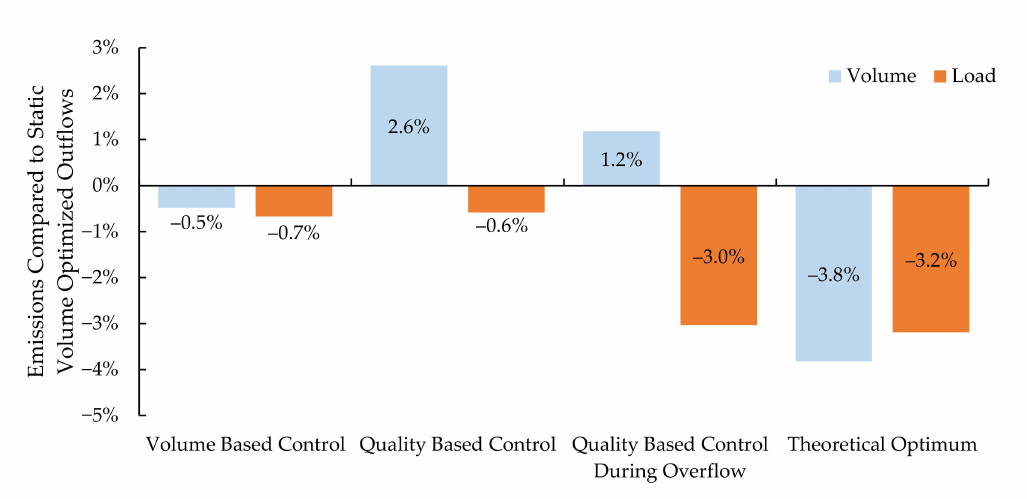
Figure 6. CSO emissions of the assessed real-time control strategies compared to CSO emissions from static volume optimized controlled